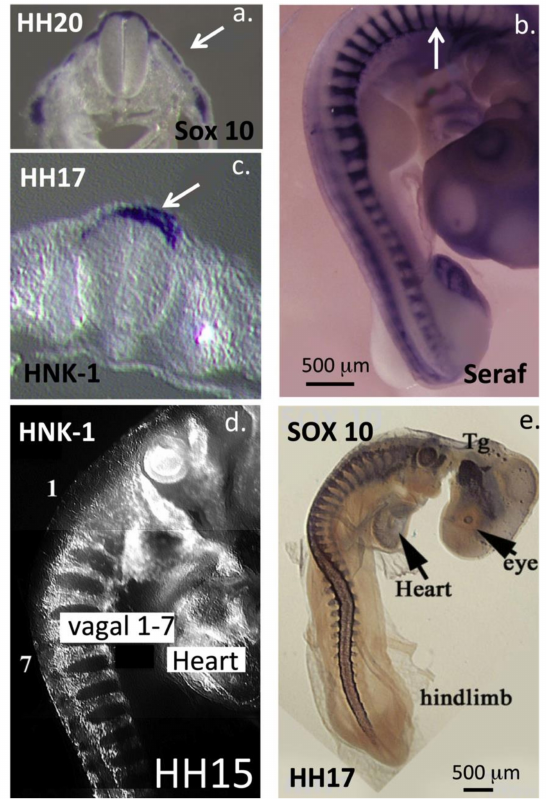
Figure 8. Demonstration of: Sox 10 ( a , e ); Seraf ( b ); and HNK-1 epitope ( c , d ) expression in